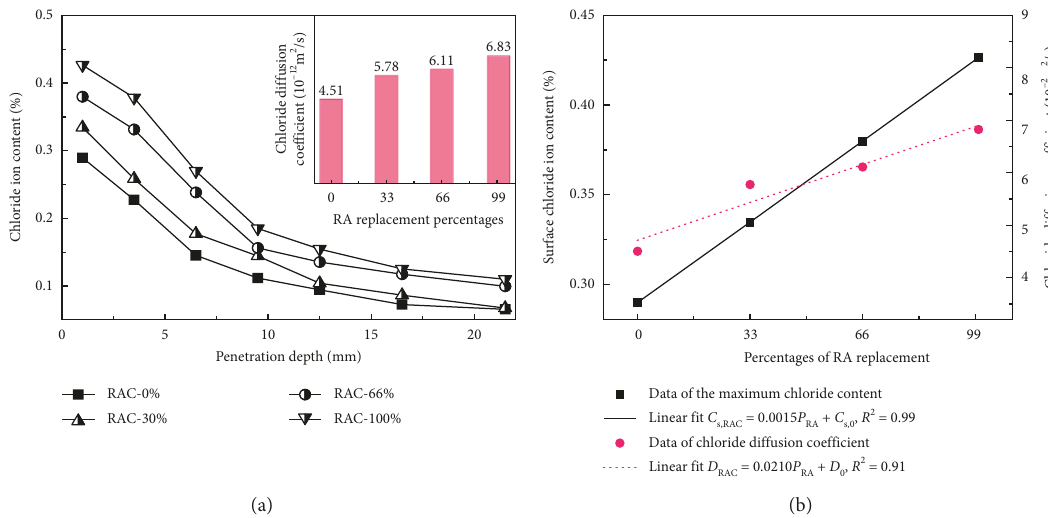
Figure 5: Chloride diffusivity of RAC without preloading damage. (a) The chloride content curves of RAC. (b) The correlation between RA content and the chloride diffusivity of the